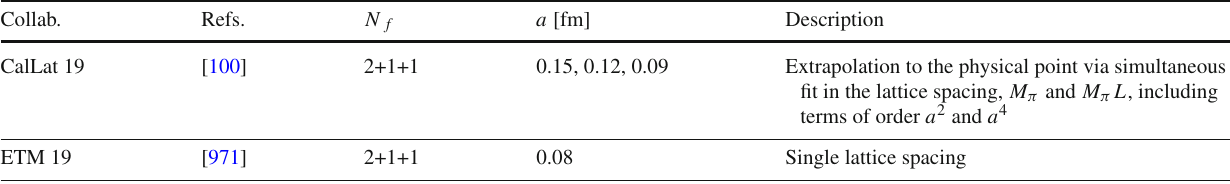
Table 174 Continuum extrapolations/estimation of lattice artifacts in determinations of the isovector axial, scalar and tensor charges with N f = 2 + 1 + 1 quark flavours Collab.